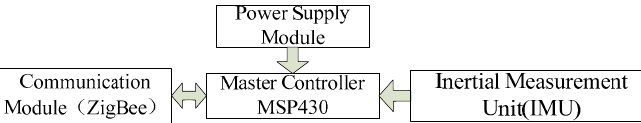
Figure 3. Design of the wireless sensor module.